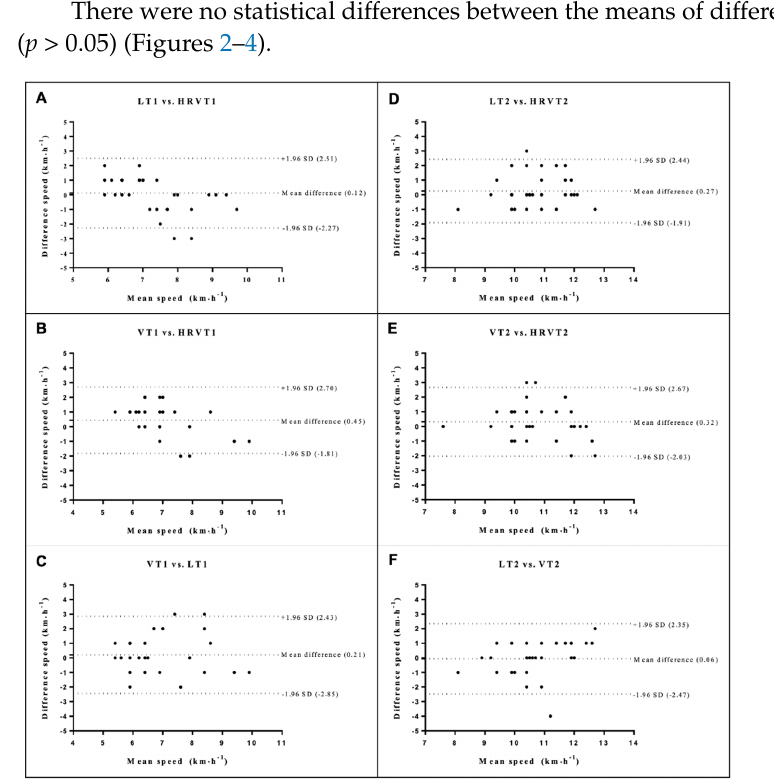
Figure 2. Bland Altman plots for speed at thresholds 1 ( A – C ) and 2 ( D – F ). The dashed lines at the ends represent the limits of agreement (1.96 SD) and the dashed central lines (bias). Lactate threshold 1 (LT1), ventilatory threshold 1 (VT1), heart rate variability threshold 1 (HRVT1), lactate threshold 2 (LT2), ventilatory threshold 2 (VT2), heart rate variability threshold 2